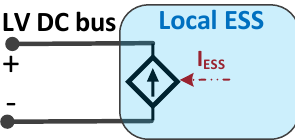
Figure 6. Block diagram of the local Energy Storage System (ESS)